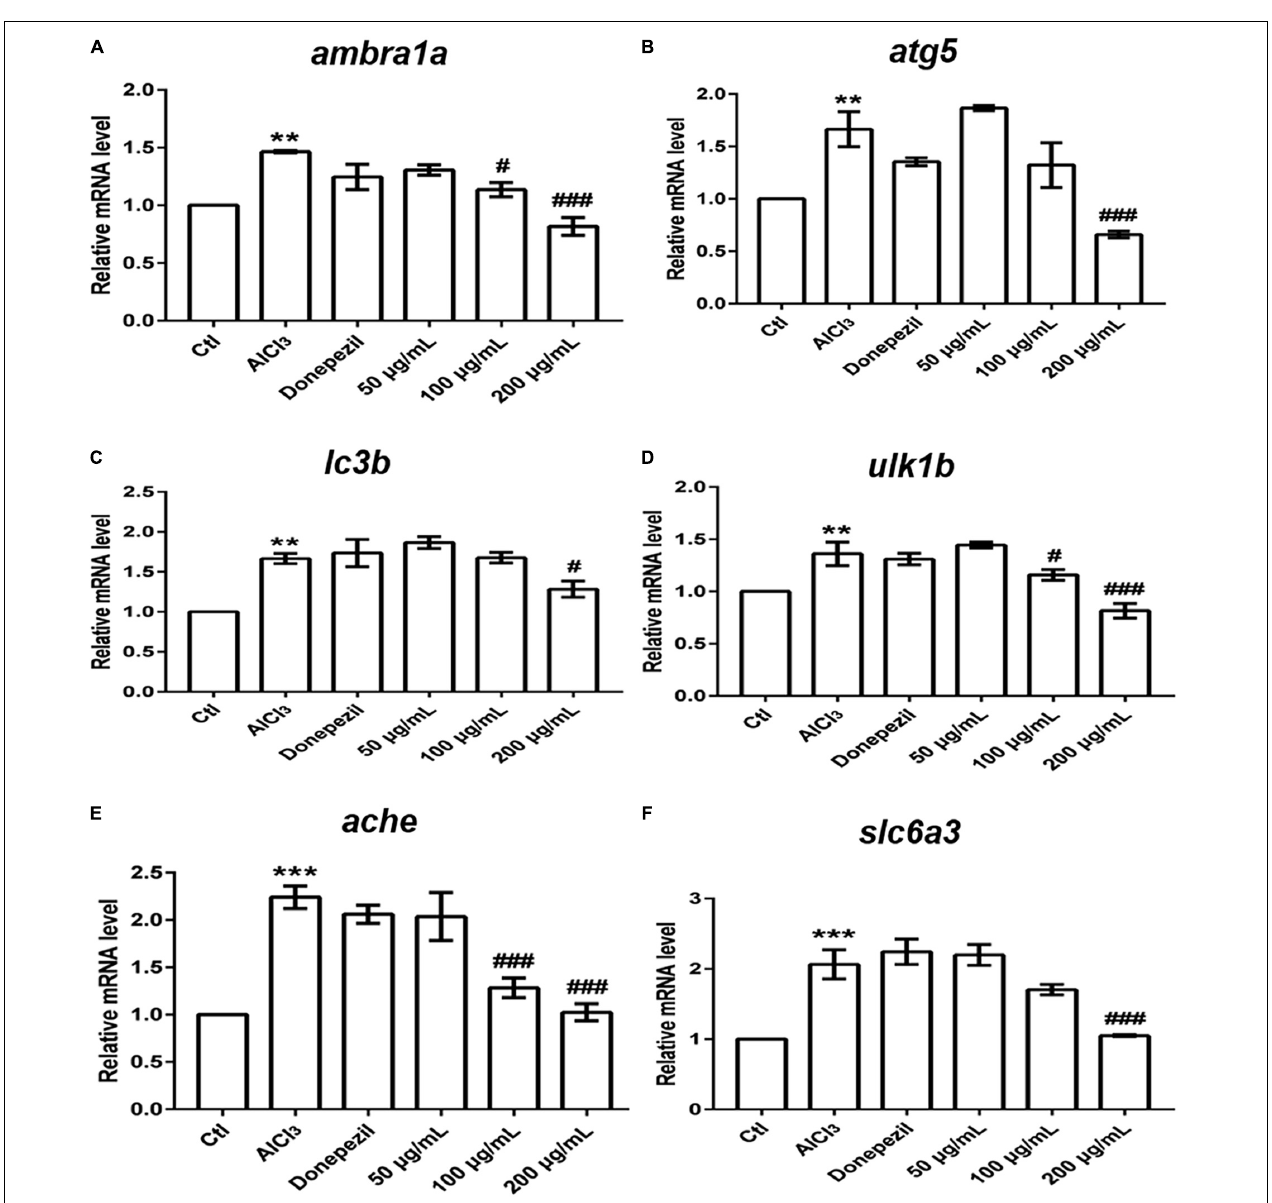
FIGURE 6 | Transcriptional alterations of genes. The amount of gene expression was exhibited as the relative expression (shown as fold) compared with the Ctl. (** P < 0.01, *** P < 0.001 vs. Ctl; # P < 0.05, ### P < 0.001 vs. AlCl 3 ). (A–D) Expressions of genes involved in autophagy. (E) Transcript levels of ache . (F) Transcript levels of slc6a3